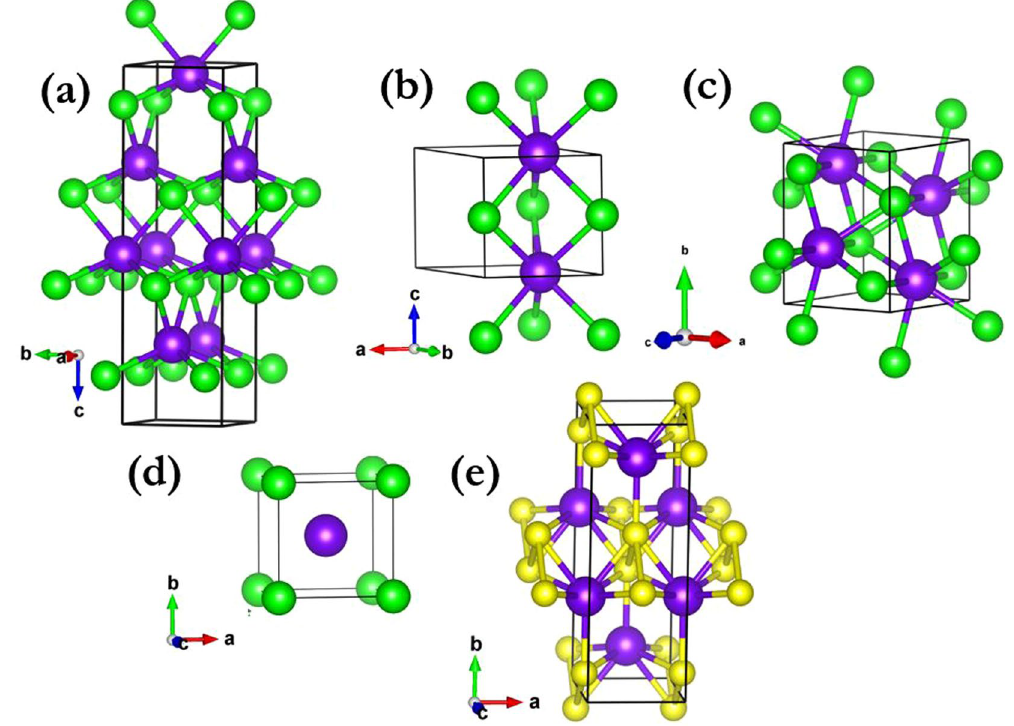
Figure 1. Crystal structures of NbAs and NbP, in which Nb, As, and P are represented as purple, green, and yellow balls, respectively. ( a ) I 4 1 md structure of NbAs at ambient pressure. ( b ) P -6m2 structure of NbAs